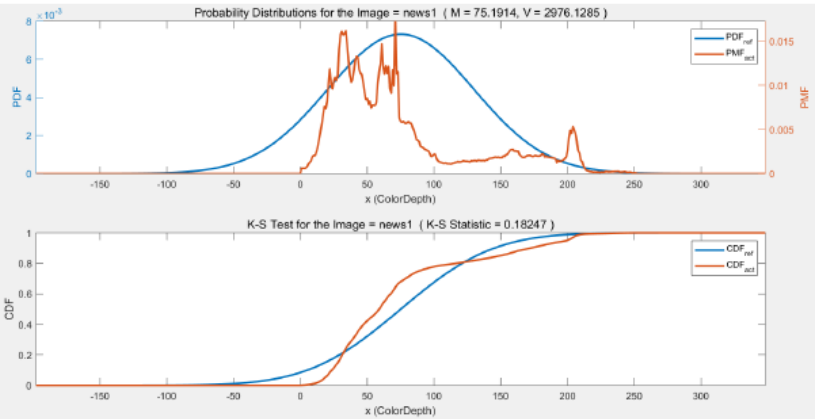
Figure 10. Histogram and Cumulative Distribution for